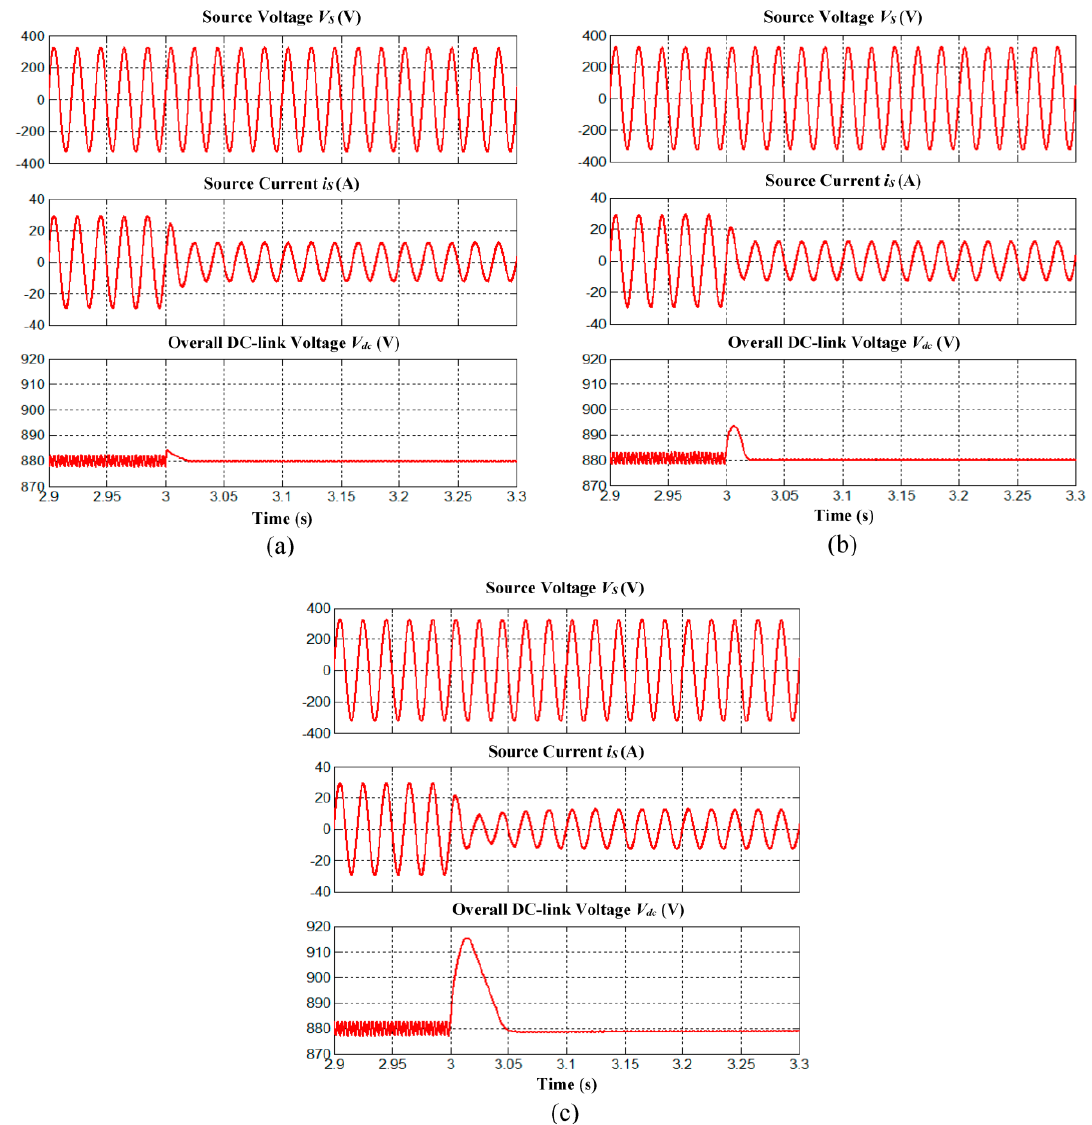
Figure 10. Simulation results of SAPF which include source voltage 𝑣 𝑆 (phase A), source current 𝑖 𝑆 (phase A) and overall DC-link voltage 𝑉 𝑑𝑐 for dynamic-state condition of capacitive to inductive load obtained using ( a ) the proposed algorithm with IED control; ( b ) the conventional algorithm with FLC and ( c ) PI techniques.